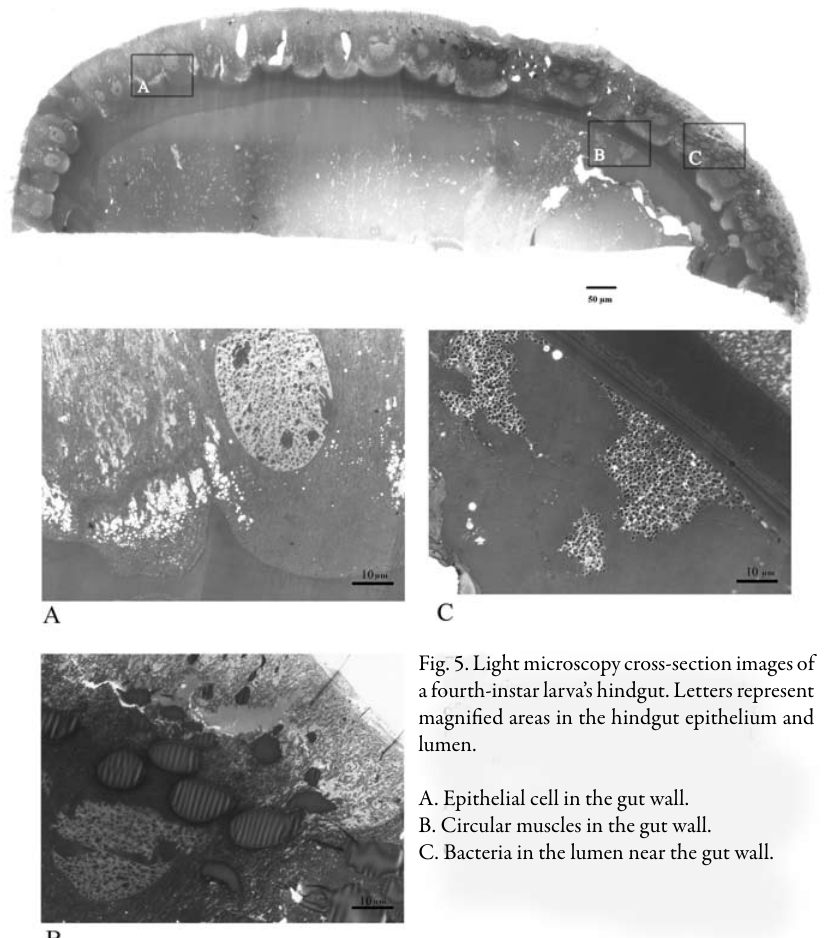
Fig. 5. Light microscopy cross-section images of a fourth-instar larva’s hindgut. Letters represent magnified areas in the hindgut epithelium and lumen. A. Epithelial cell in the gut wall. B. circular muscles in the gut wall. c. Bacteria in the lumen near the gut